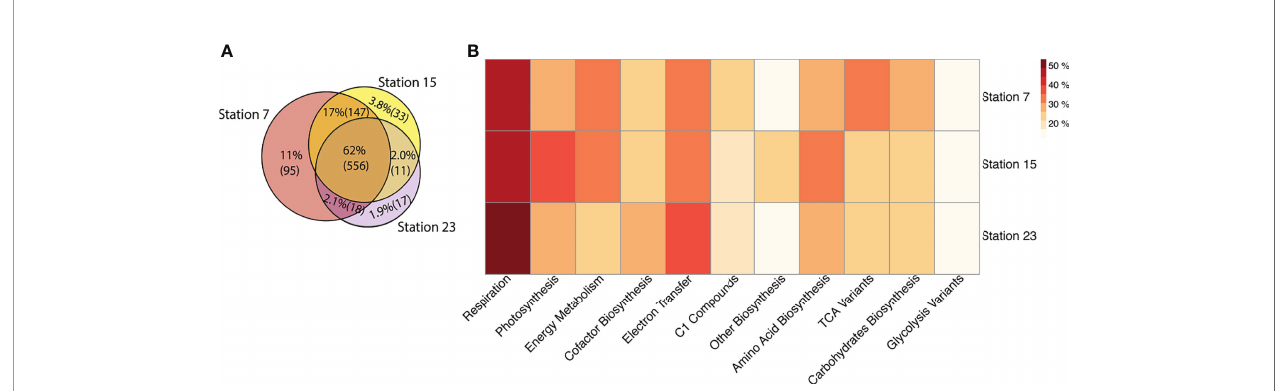
FIGURE 8 | Metatranscriptomic pathway distribution patterns at Stations 7, 15, and 23 along the cruise transect. (A) Venn diagram, demonstrating percent (and number) of metatranscriptomic pathways shared amongst the stations. (B) Heatmap of the broader functional classes to which the top 20 metatranscriptomic pathways belong to, with darker red colours depicting a stronger presence, and lighter yellow colours depicting a weaker presence of a pathway at a